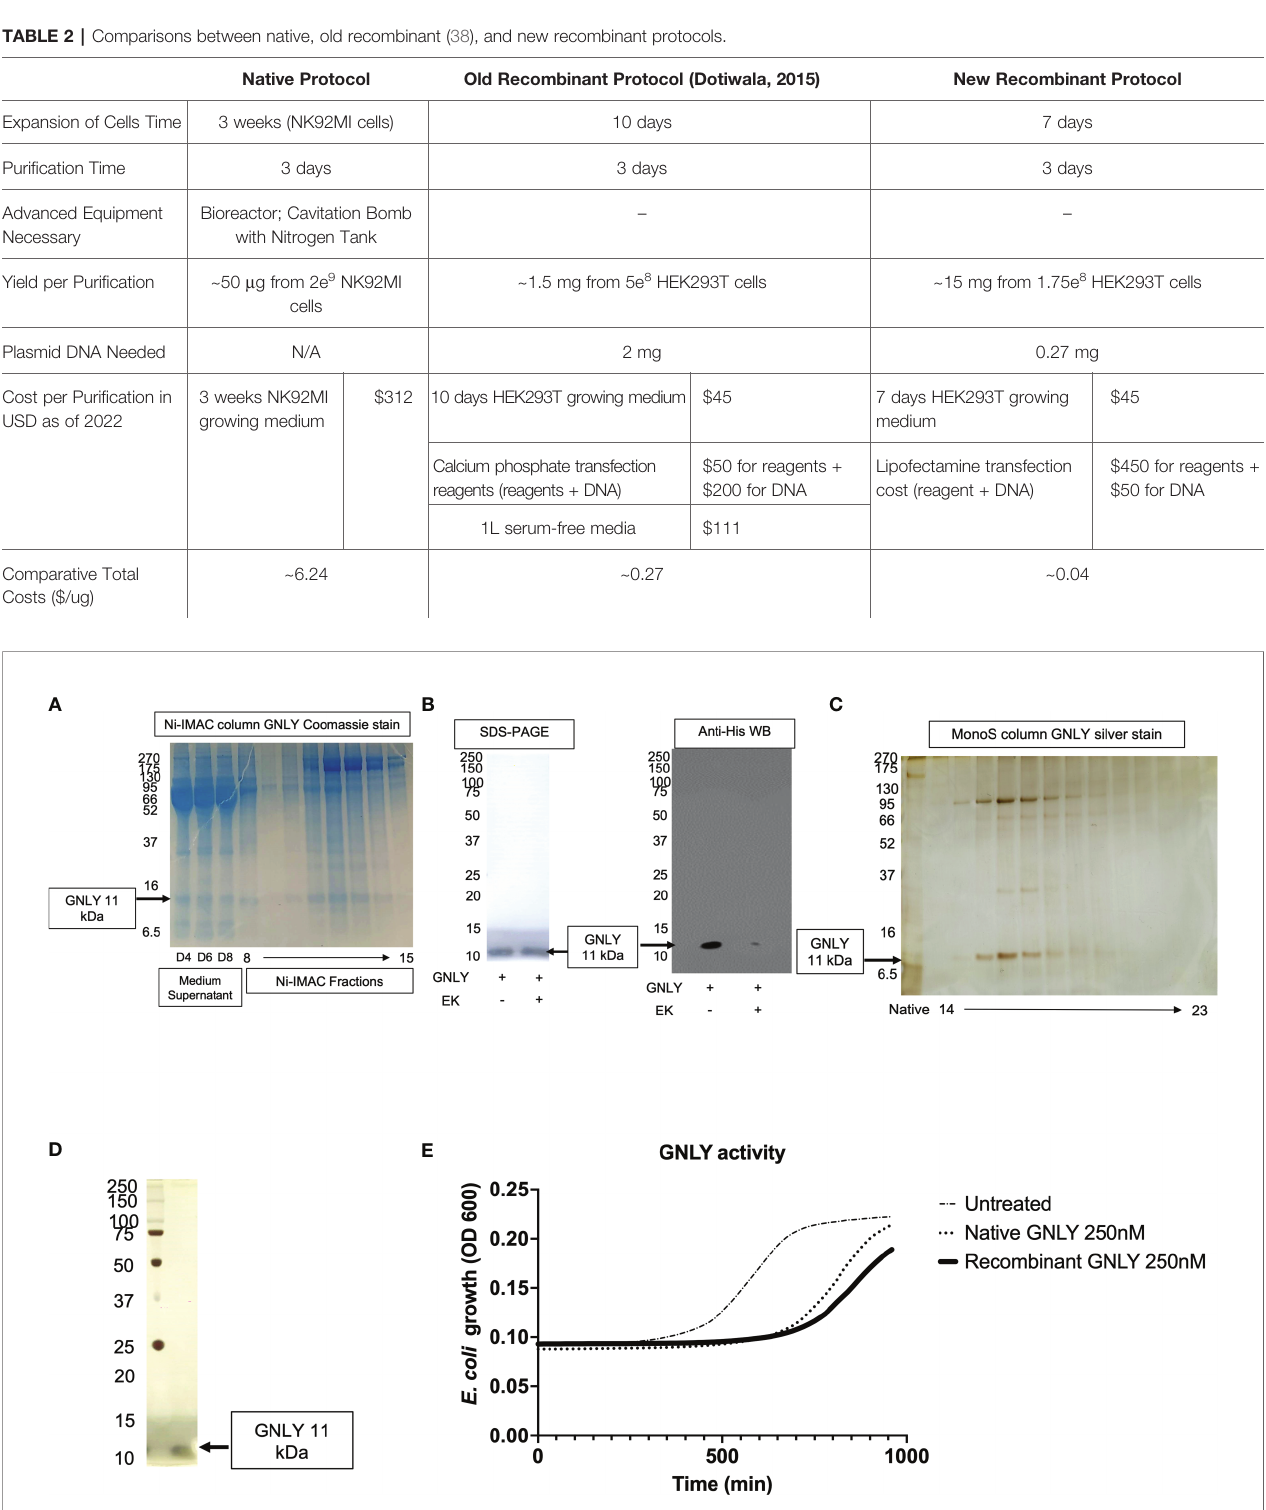
FIGURE 5 | Mammalian GNLY production: puri fi cation, activation, and characterization. (A) GNLY (11 kDa bands) is secreted into the supernatants of transiently transfected cells and detected at D4, D6, and D8. Ni-IMAC fractions are tested by Coomassie-stained SDS-PAGE to con fi rm GNLY separation. On the left, MW markers. (B) Loading control for GNLY on the left under SDS-PAGE, while on the right GNLY activation EK activation (loss of His-tag). On the left, MW markers. (C) Native GNLY in lane 2 for comparison and MonoS fractions (14 through 23) after silver staining. On the left, MW markers. (D) GNLY purity was assessed by SDS-PAGE after GNLY + MonoS fractions were pooled together. On the left, MW markers. (E) GNLY-mediated inhibition of E . coli and comparison between native and recombinant samples using 250 nM of